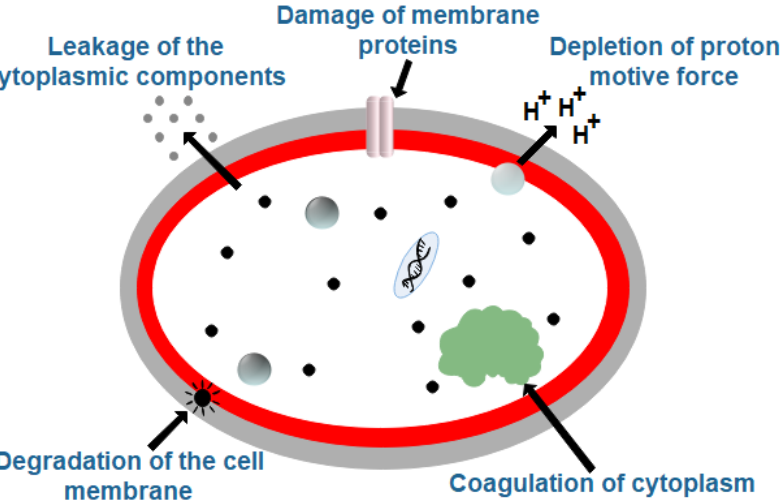
Figure 11. Plausible mechanisms of antimicrobial activity of the essential oils. Redrawn from